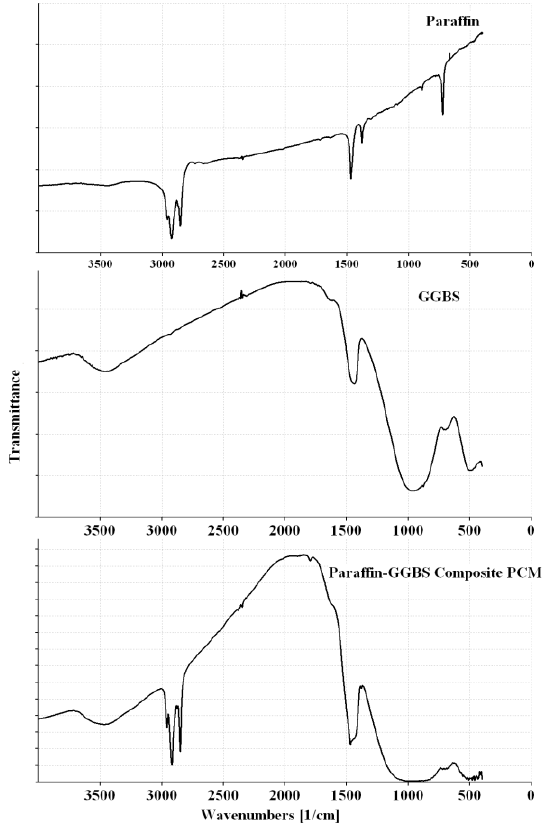
Figure 4. FT-IR spectra of Paraffin, Kaolin and Paraffin-Kaolin composite PCM.